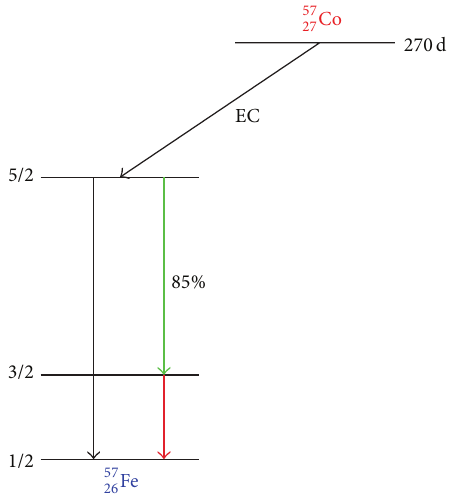
Figure 10: The principle of Mossbauer spectroscopy. The nuclear reactions in Mossbauer source cause the desired spectroscopy [123].